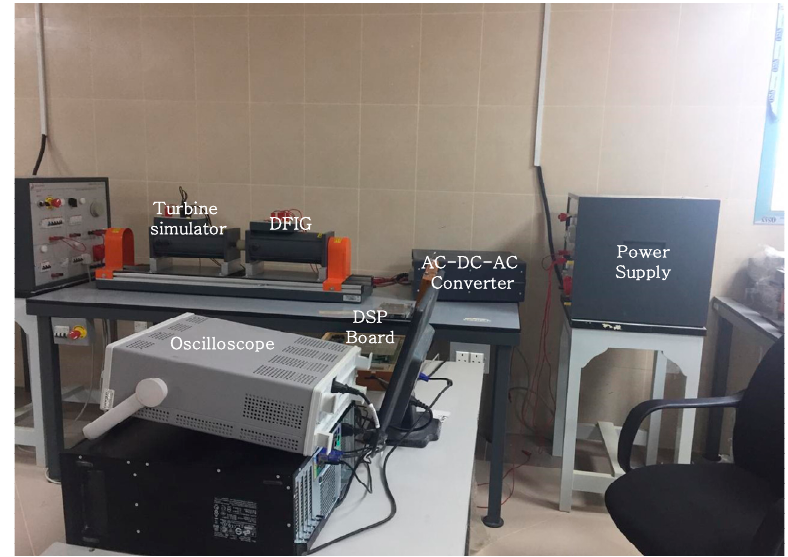
Figure 15. Layout of the experimental equipment.